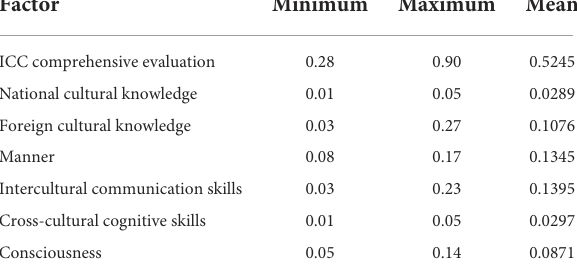
TABLE 4 Distribution of survey